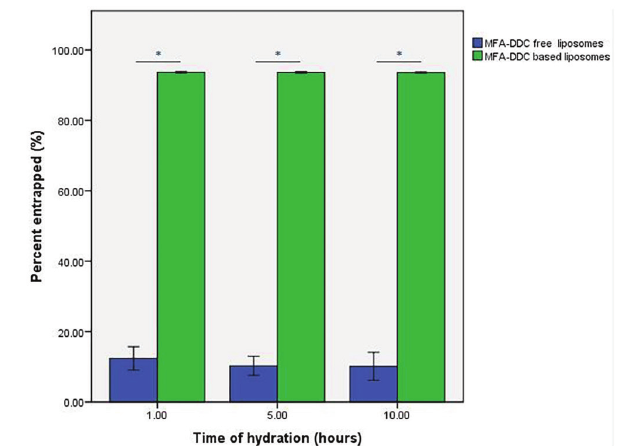
FIGURE 3 - Entrapment efficiency (%) when different liposomal components and duration of hydration were employed. (*) Indicates statistically significant difference between the formulations by the Student’s t-test.